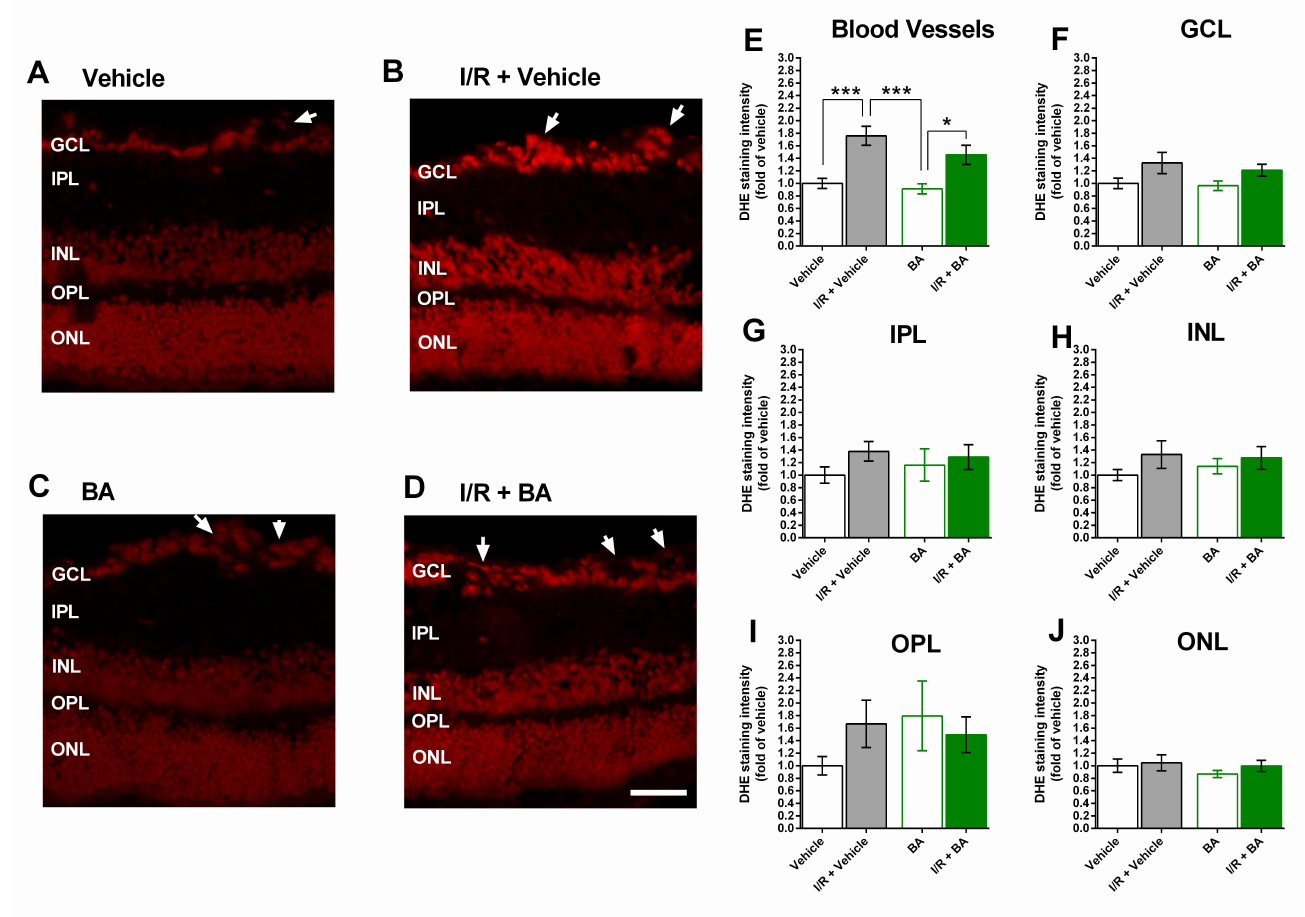
Figure 3. Dihydroethidium (DHE) staining in retinal cross-sections. ( A – D ) Representative pictures of retinal cross-sections from each group. Scale bar = 50 µ m. ( E – J ) DHE staining intensity was markedly increased in retinal blood vessels from I/R- and vehicle-treated eyes ( E ). In none of the retinal layers, marked differences in DHE staining intensity were observed among groups ( F – J ) (GCL, ganglion cell layer; IPL, inner plexiform layer; INL, inner nuclear layer; OPL, outer plexiform layer; ONL, outer nuclear layer; *** p < 0.001; * p < 0.05; n = 8 per